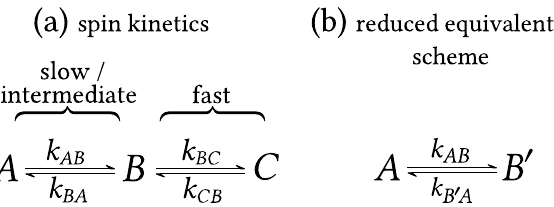
Figure 4. Consecutive three-state exchange containing a fast exchange process. ( a ) Spin kinetics scheme and ( b ) the corresponding reduced equivalent